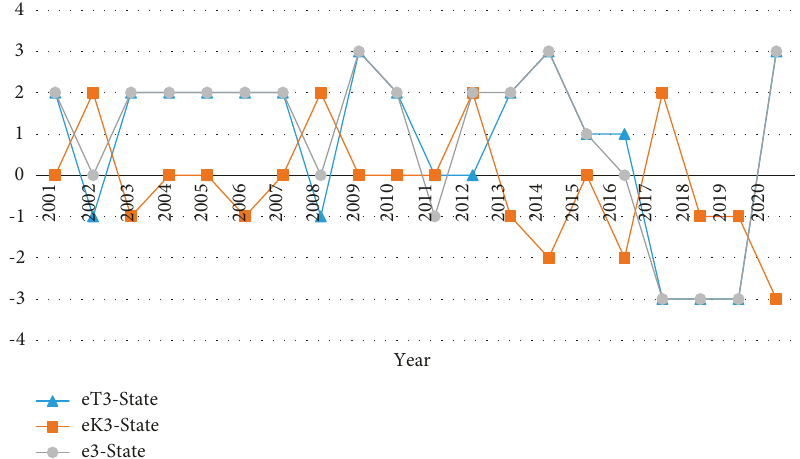
Figure 15: Decoupling of energy efficiency, energy structure, and carbon emission of the ferrous metal sector from 2001 to 2020.